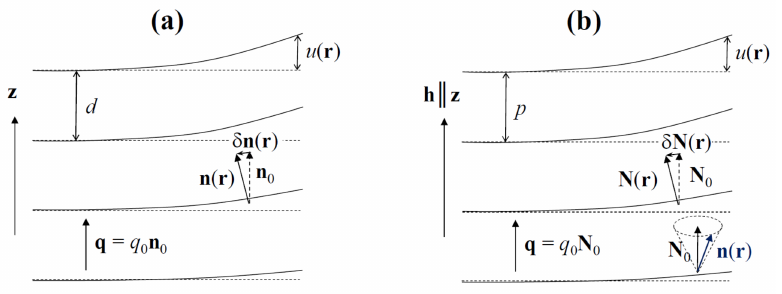
Figure 2. The analogy between the layered structure of the SmA* phase ( a ) and the pseudo-layered structure of the N TB phase ( b